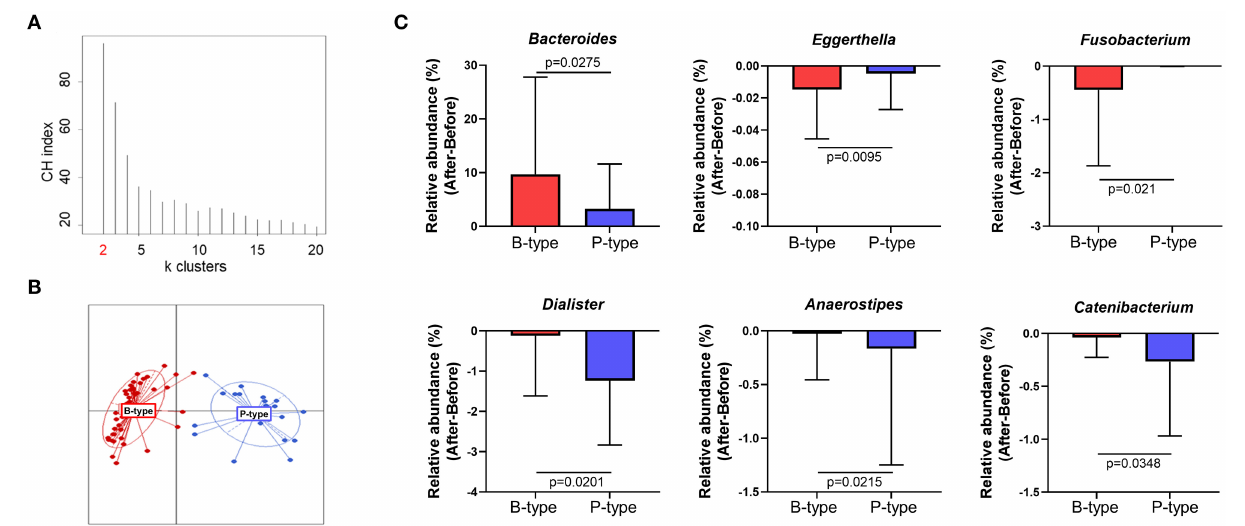
FIGURE 4 | Changes in gut microbial composition after Saengshik supplementation according to enterotype. (A) Calinski–Harabasz (CH) indices for the number of potential clusters of samples. The x and y axes show the cluster number and CH index, respectively. The highest CH index refers to an optimal number of clusters. (B) Clustering based on the first two principal coordinates of the Jensen–Shannon distances of the relative abundance of the genus. Red color represents the Bacteroides -enriched enterotype (B-type; n = 43), and blue color represents the Prevotella -enriched enterotype (P-type; n = 23). Lines represent distances of points from centroids; ellipses show areas of highest density. (C) Changes in the relative abundance of significantly different gut bacterial genus between B-type (red; n = 43) and P-type (blue; n = 23) groups. The vertical axis shows the alternation of relative abundance, which is the delta value between the relative abundance (%) of samples before and after the intervention in each enterotype (After minus Before in P-type and B-type). P -values according to multiple t -tests were adjusted by the Benjamini–Hochberg false discovery rate (q <